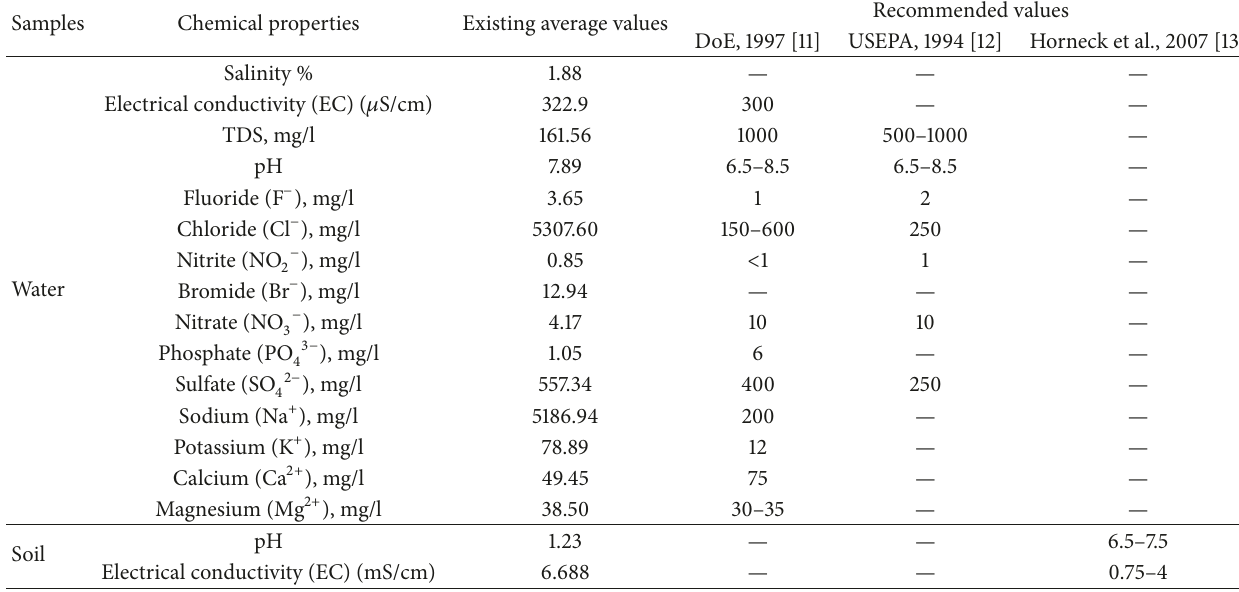
Table 7: Existing and recommended values of salinity indicators in soil and water samples. Samples